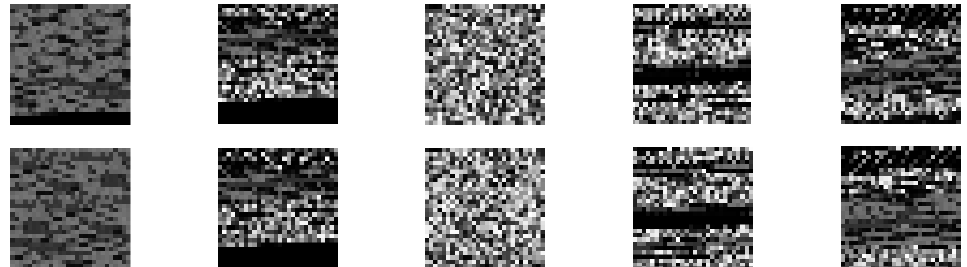
Figure 6. Traffic visualizations of trojan Zeus (the first column), Skype (the second column), Outlook (the third column), backdoor Htbot (fourth column) and botnet Virut (fifth column). Images were cre- ated by the authors with the advantage of the tool introduced in [34] on the USTC-TFC2016 dataset.